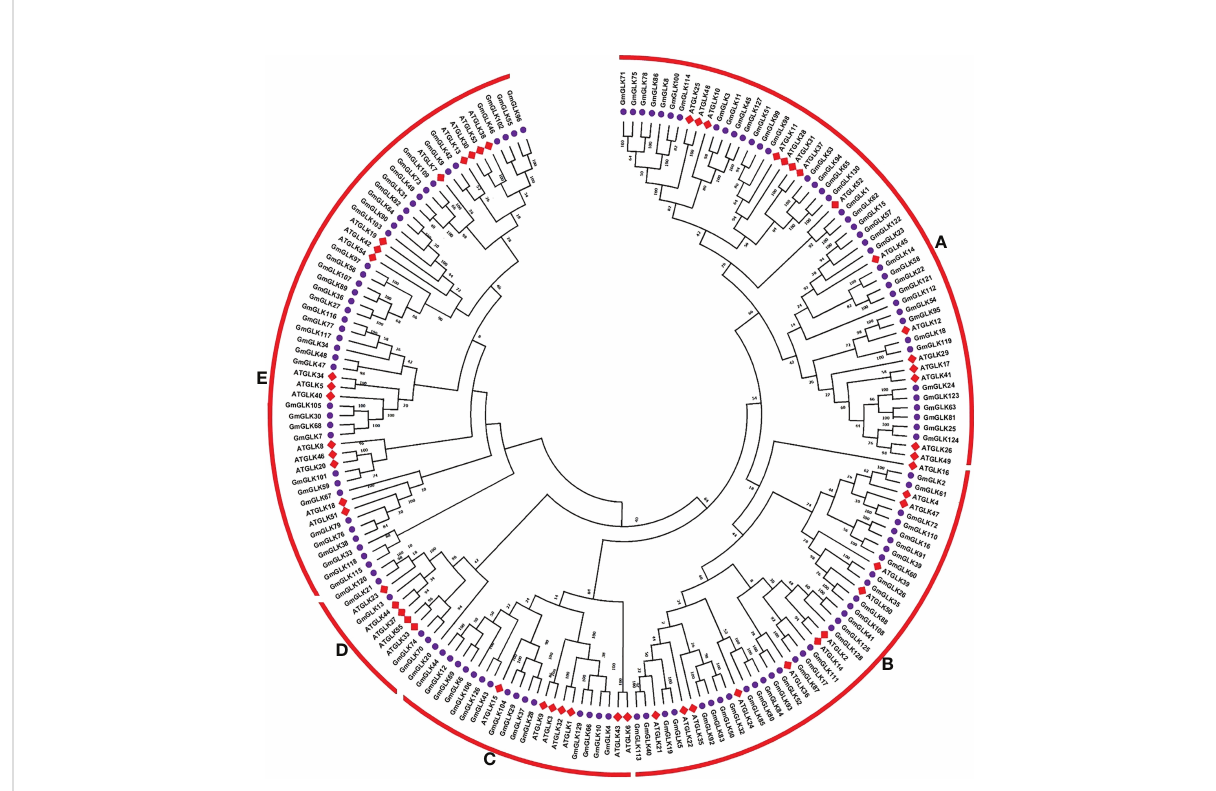
FIGURE 1 Phylogenetic tree and classi fi cation of Glycine max and A. thaliana GLK proteins. The ML-hood with Jones Taylor Thornton (JTT) model tree was constructed using MEGAX. The bootstrap support from 1000 replications is transformed to each node. The GLK proteins were clustered into fi ve major groups (A – E)